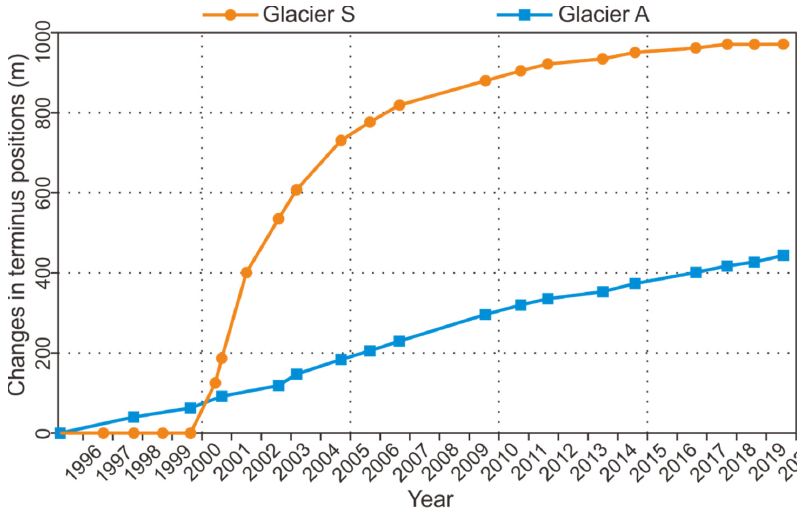
Figure 2. Satellite images of the two studied glaciers at different time. Six images on the left are false- color combination of Landsat series and the big image on the right is from Google Earth. The white and yellow lines, respectively, indicate the terminus positions in 2000 and 2019.